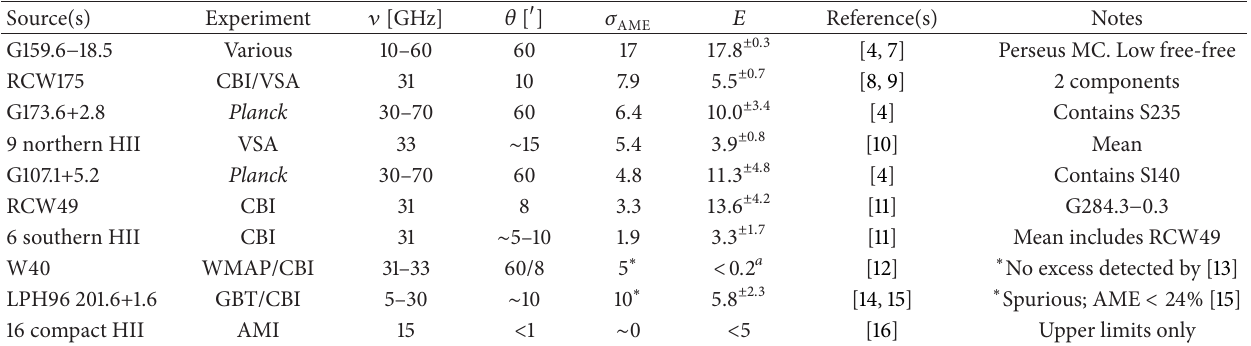
Table 1: Summary of observations of AME from HII regions. The entries are listed according to their approximate detection significance, 𝜎 . The angular sizes are approximate or refer to the telescope beam. 𝐸 is the AME emissivity relative to 100 𝜇 m, in units 𝜇 AME